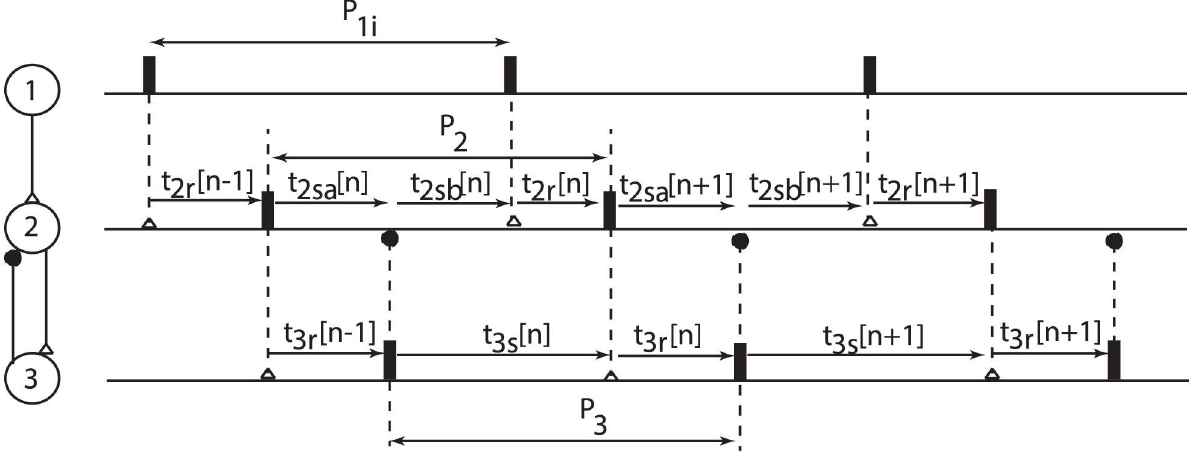
Fig 3. Typical phase-locked mode with one neuron receiving two inputs per cycle. Neuron#1 is the driver of the entire network and its intrinsic firing period P 1 i was used as reference durationfor all other intrinsic periods. The neuron’sspike is represented by a thick vertical line. The couplingbetweenthe neuronsis marked by vertical dashedlines that terminate either with an excitatory (empty triangle)or a inhibitory(solidcircle) synapse. Neuron#2 receives 2 inputs duringone cycle: the first is an inhibitionat stimulus time t 2 sa from the interneuron #3 and later on it receives an excitatory input from neuron#1 at stimulus time t 2 sb . The neuronrecovers from the last stimulus after t 2 r and fires again. Neuron #3 only receives one excitatory input per cycle from neuron#2.